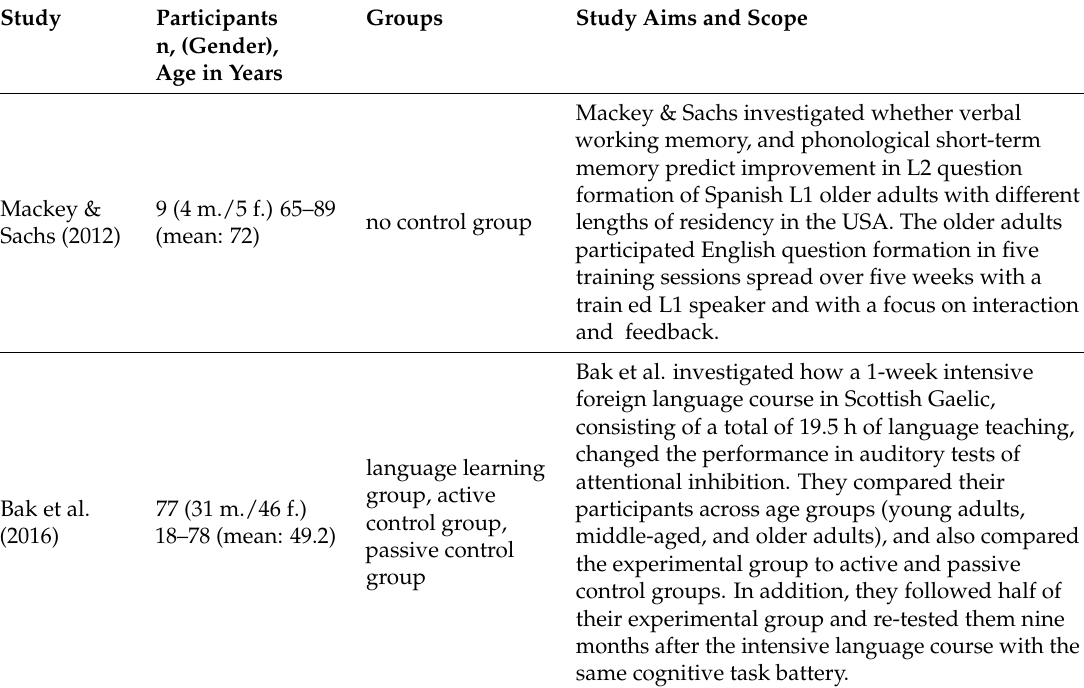
Table 1. Participant setup and general research questions of the included